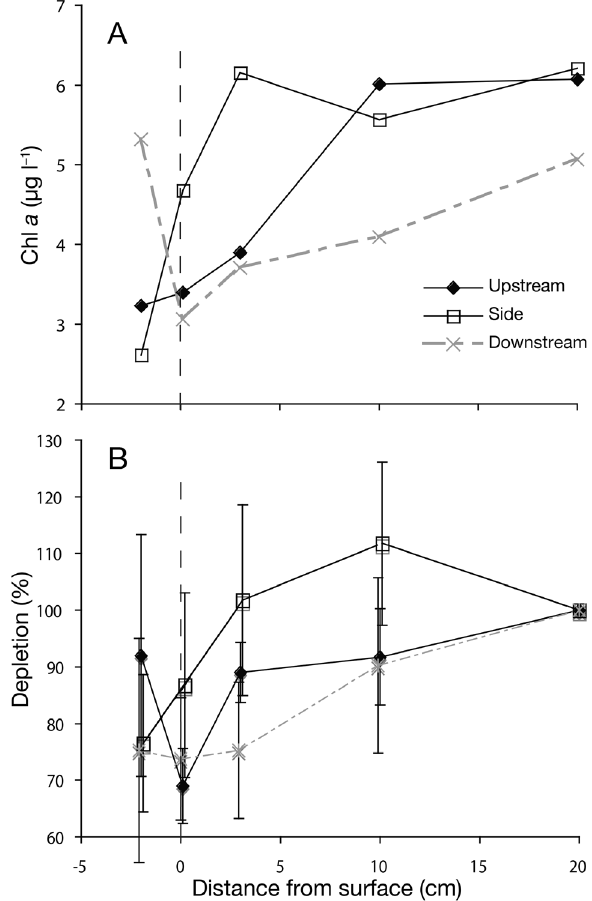
Fig. 8. Depletion of chl a measured in the boundary layer within centimeters from the mussel bands. Upstream: siphon mimic pointed against the flow; side: perpendicular to main flow; downstream: pointed in the flow direction. (A) Exam- ple of chlorophyll concentration patterns with distance from a mussel band; (B) average depletion using 20 cm as refer- ence for 3 replicates on 4 different days. Dashed vertical line: surface of the mussel